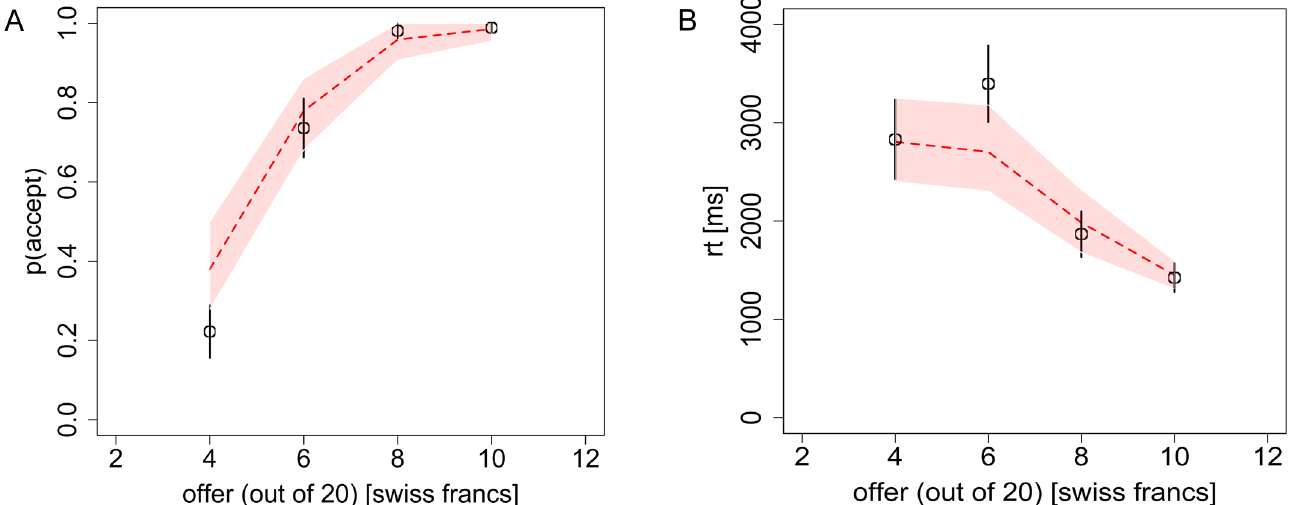
Fig 5. Choices and reaction times from Task 4 (Ultimatum game). A) The probability of the receiver accepting an ultimatum offer, and B) the RT, as a function of the offer (out of a possible 20 Swiss Francs). Black circles indicate the aggregate subject data with bars representing s.e.m. Red dashed lines indicate the DDM predictions with 95% confidence intervals. Overlap of these confidence intervals with the data ’ s standard error bars in every case, indicates excellent model